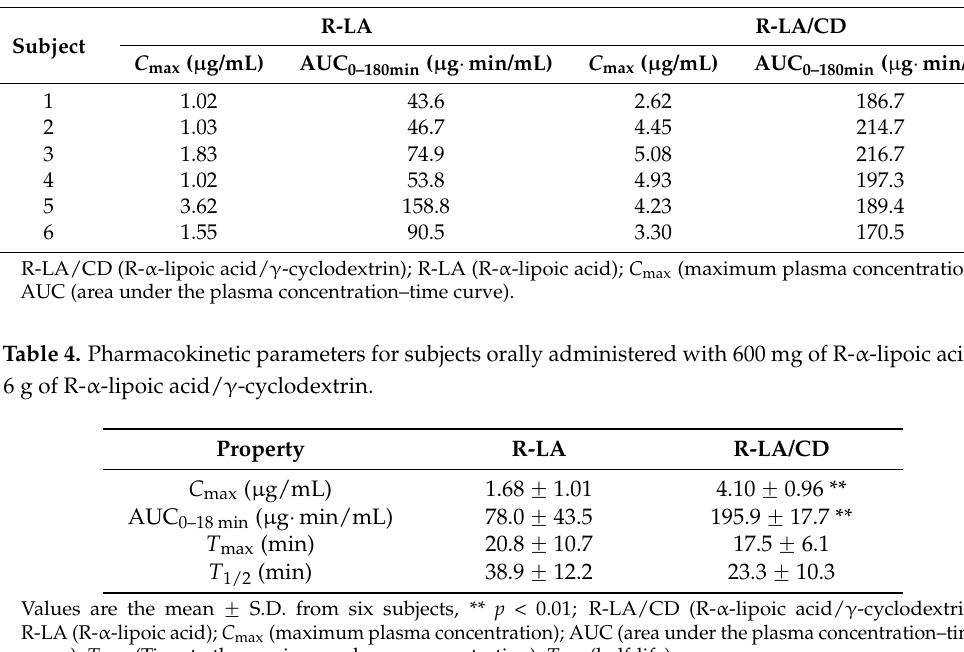
Figure 2. Plasma concentrations of R- α -lipoic acid following a single oral 600-mg dose of R- α -lipoic acid or 6 g of R- α -lipoic acid/ γ -cyclodextrin in healthy volunteers. Values are the mean ± S.D. from six subjects. * p < 0.05 and ** p < 0.01; R-LA/CD (R- α -lipoic acid/ γ -cyclodextrin); R-LA (R- α -lipoic acid); Note: 6 g of R-LA/CD is the equivalent amount of 600 mg of R-LA. Table 3. Pharmacokinetic parameters of individual subjects administrated with a single oral 600-mg dose of R- α -lipoic acid or 6 g of R- α -lipoic acid/ γ -cyclodextrin.